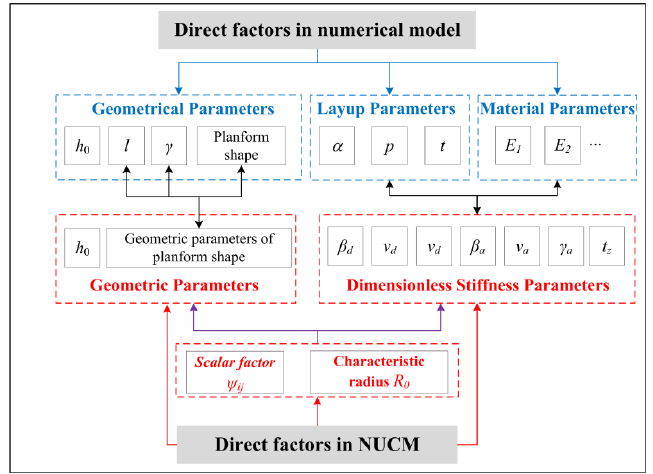
Figure 3. Relationships of the direct factors between the numerical model and non-uniform curvature model (NUCM).